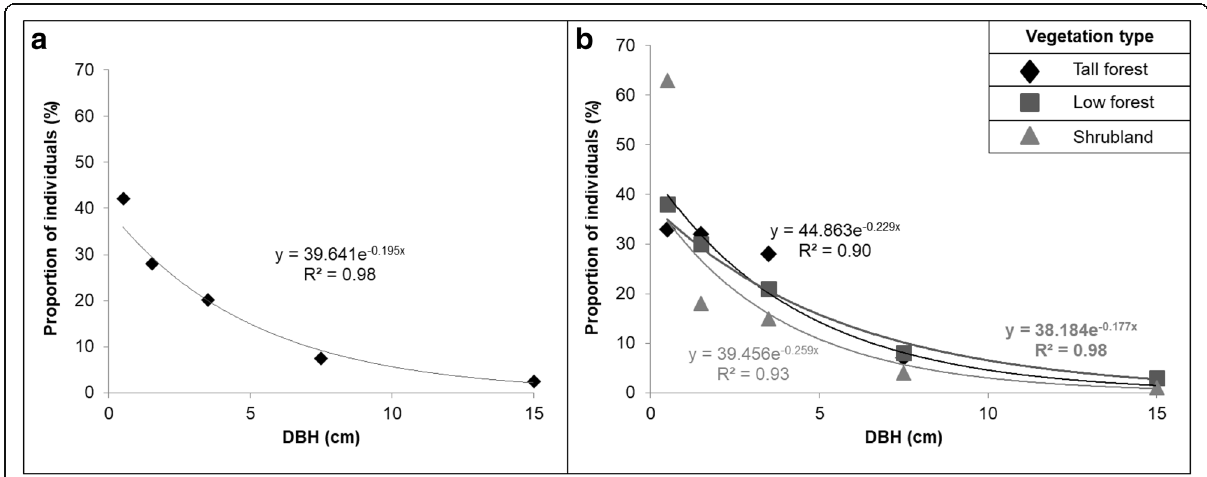
Fig. 5 Survival curve. a Survival for total population of tropical ash. b Population survival by vegetation types